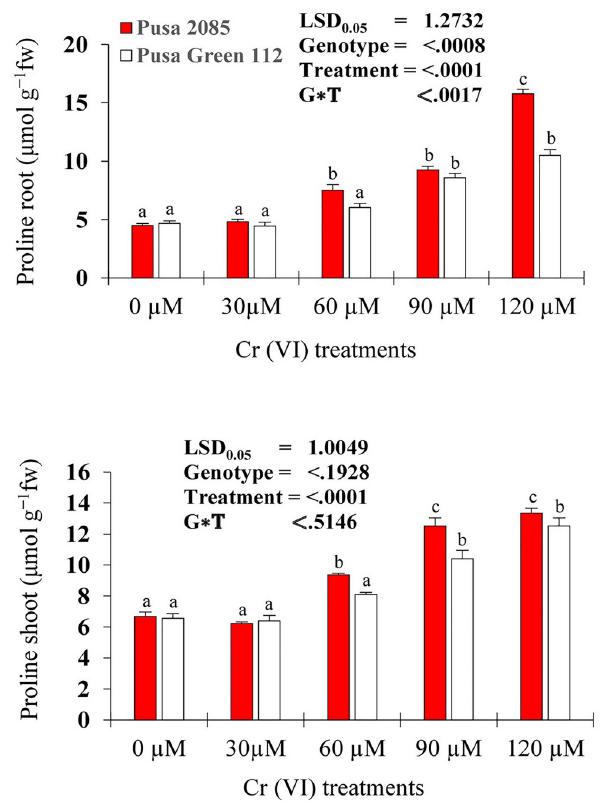
Fig 6. Effects of the various chromium (Cr) concentrations on the proline contents in roots and shoots of two chickpea varieties (Pusa 2085 and Pusa Green 112) 21 days after treatment (DAT). Values are means ± standard errors from three independent experiments. Error bars with the same letters are not significantly different at p � 0.05.